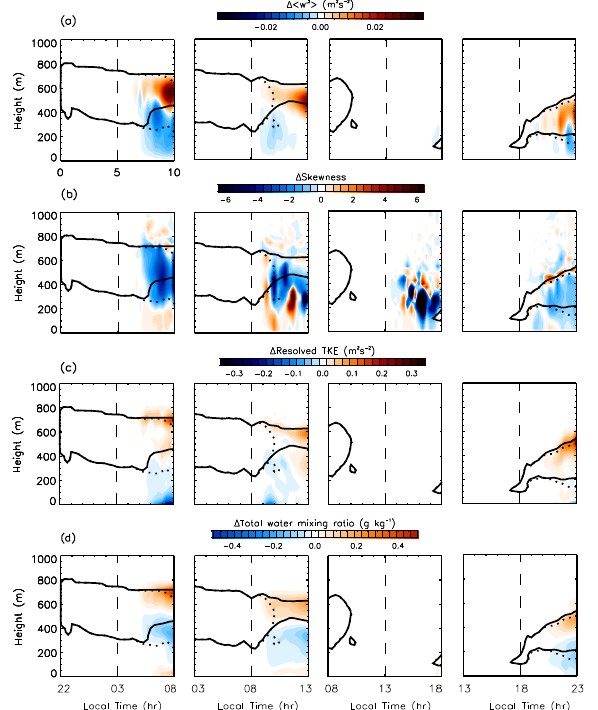
Fig. 6. Time evolution for WP SA0.5 injection-induced perturba- tions in domain averaged: (a) vertical velocity variance ( <w 0 2 > , m 2 s − 2 ) ; (b) vertical velocity skewness; (c) resolved turbulent ki- netic energy (m 2 s − 2 ) ; and (d) total water mixing ratio (g kg − 1 Solid lines indicate the perturbed domain average cloud top and base (contour at cloud water mixing ratio of 0.01gkg − 1 trol case domain average cloud top and base are indicated by the dotted lines. The dashed vertical lines indicate the time of aerosol injection.